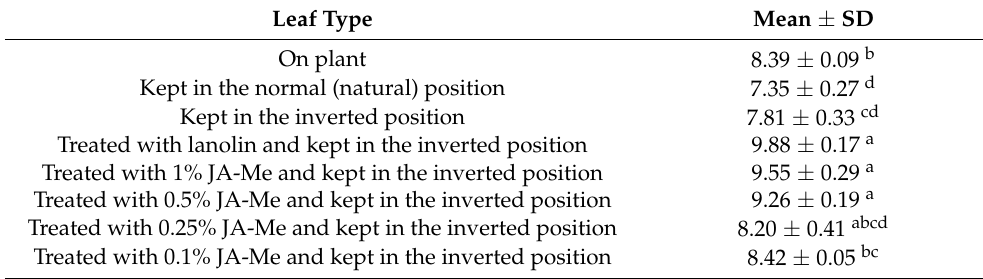
Table 2. Proanthocyanidins content ( µ Mol/g DW) in the leaves of K. blossfeldiana on the plant and in leaves detached from the plant and kept for 4 days in the normal (natural) position, kept for 4 days in the inverted position, and kept for 4 days in the inverted position after treatment with various concentrations of methyl jasmonate (JA-Me) in lanolin paste. Mean results ± standard deviation (SD) followed by the same letter were not significantly different ( p < 0.05) according to Tukey’s test. Leaf Type Mean ± SD On plant 8.39 ± 0.09 b Kept in the normal (natural) position Kept in the inverted position